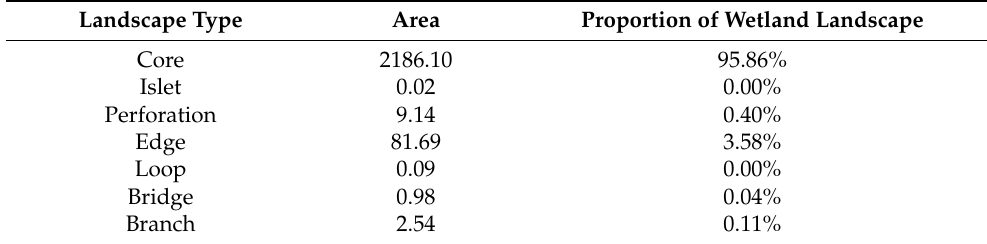
Table 4. Statistics of wetland landscape types based on